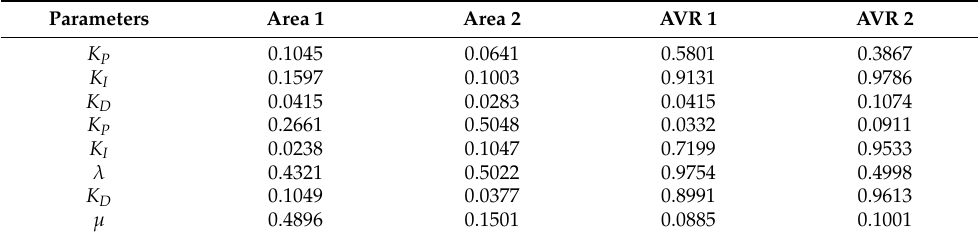
Figure 11. Dynamic responses with different case of GCSC and SMES coordination’s: ( a ) ∆ f 1 ; ( b ) ∆ f 2 ; ( c ) ∆ P tie ; ( d ) V t1 ; ( e ) V t2 . Table 14. Numerical values of T s (s) , M P , and U P for AGC. Coordination